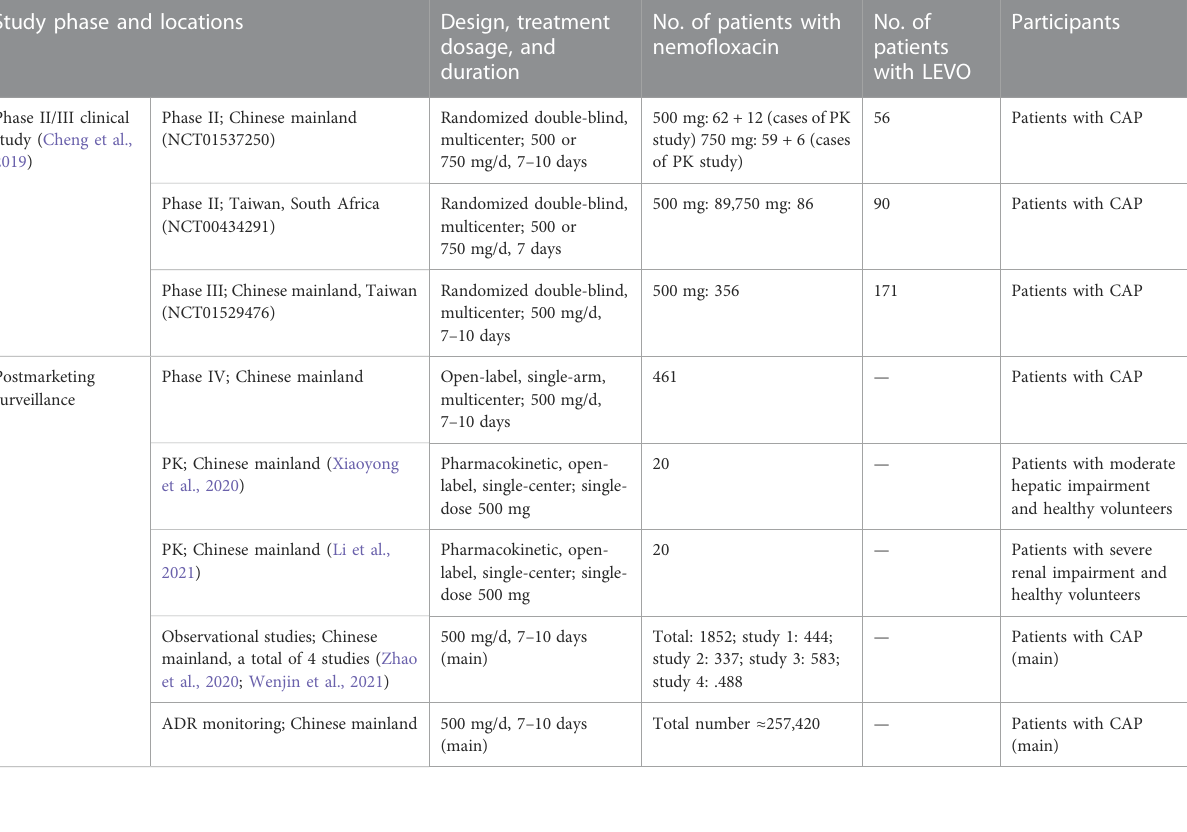
TABLE 2 Safety summary of nemonoxacin in Phase II/III clinical studies. AEs